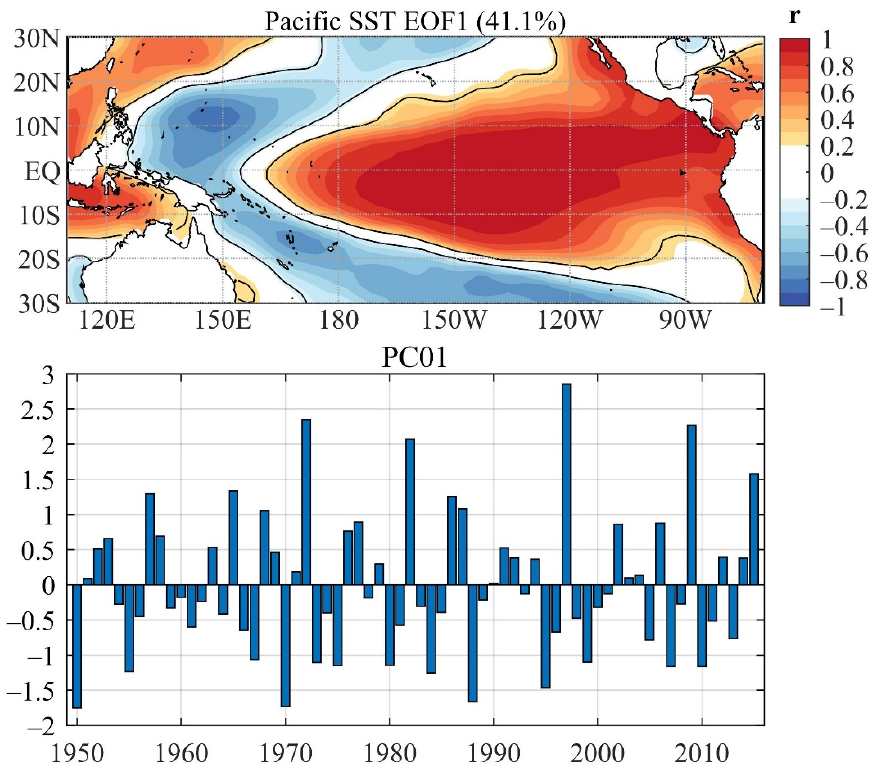
Figure 1. First EOF mode of the interannual SST anomalies in the tropical Pacific Ocean computed for the southern summers of the 1951–2016 period: spatial loading pattern and principal component (PC) time series. Continuous line encompasses the significant correlations at a 95% confidence level using Student’s t ‐ test .